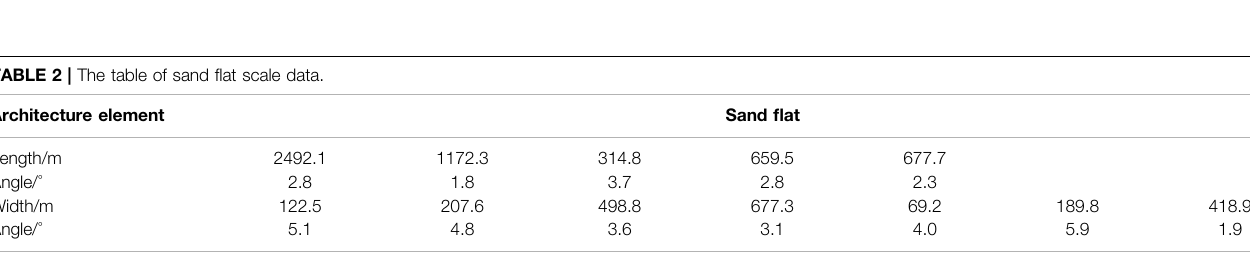
TABLE 2 | The table of sand fl at scale